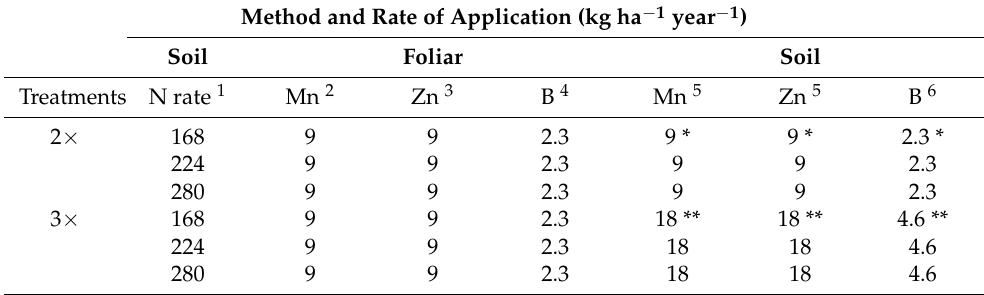
Table 1. Soil and/or foliar applied essential nutrients on HLB-affected citrus trees at Immokalee, FL during the 2016–2018 growing